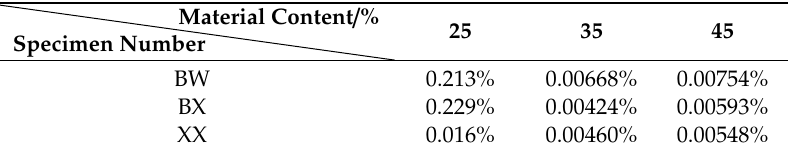
Table 11. Standard deviation analysis comparison table of thermal conductivity of di ff erent thermal insulation materials.